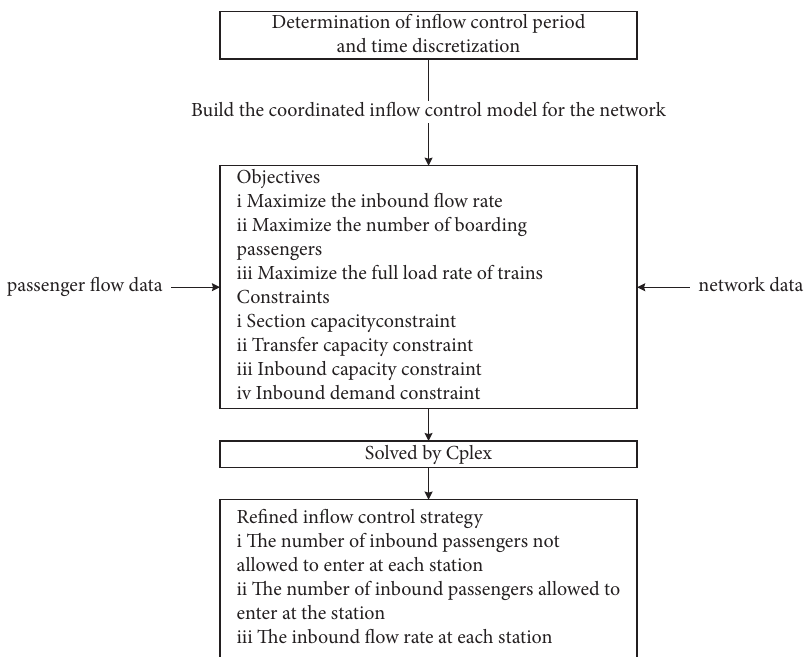
Figure 3: Solving process of the coordinated inflow control model.